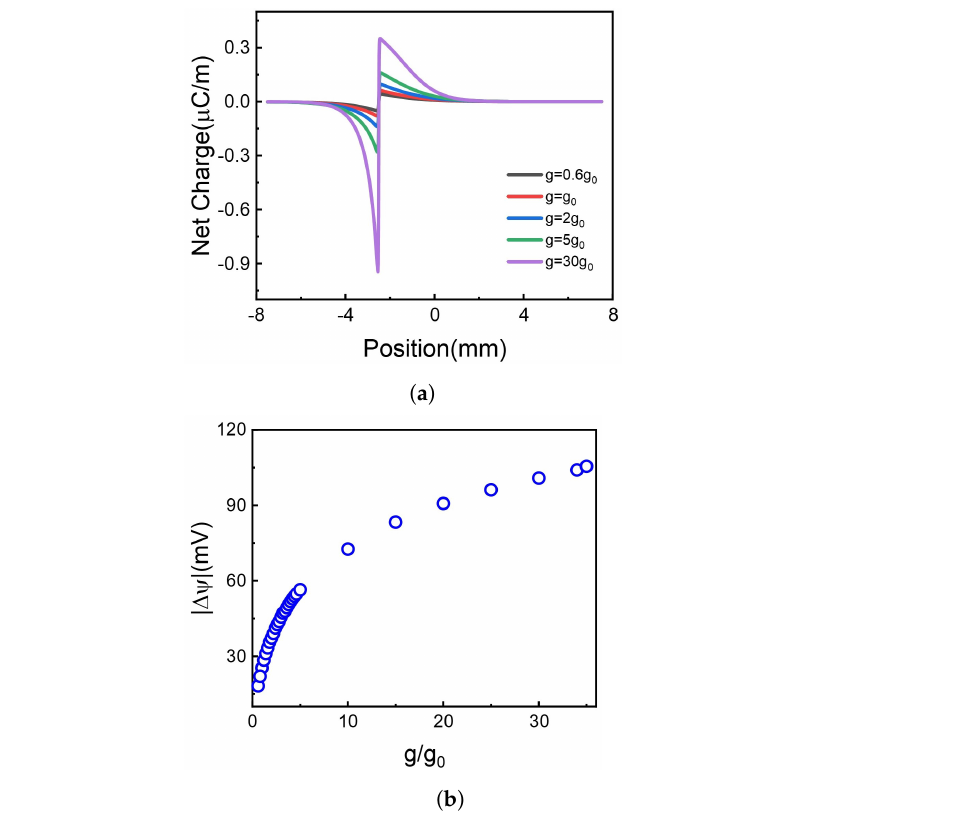
Figure 4. The net charge distribution and the corresponding voltage difference at different photore- sponsivity. ( a ) Net charge distribution. ( b ) Voltage